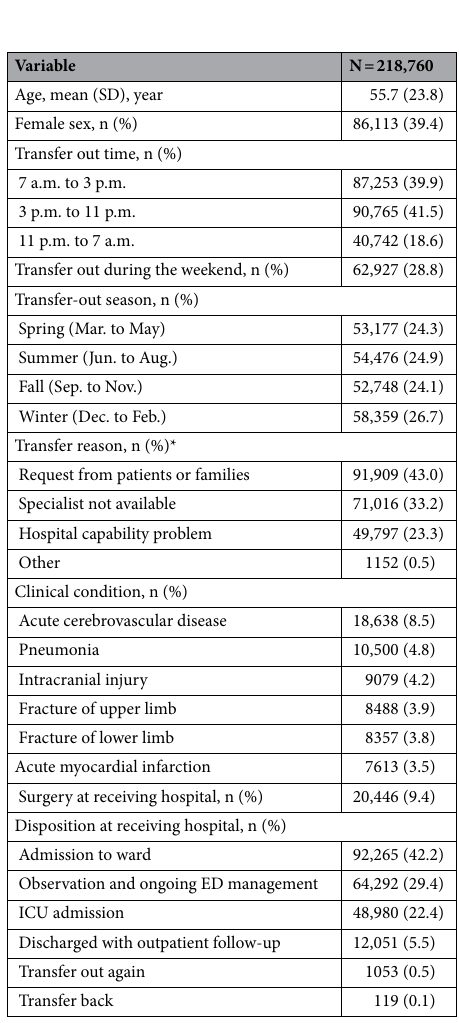
Table 1. Characteristics of emergency department transfers. SD standard deviation, ED emergency department, ICU intensive care unit. *Available for 213,874